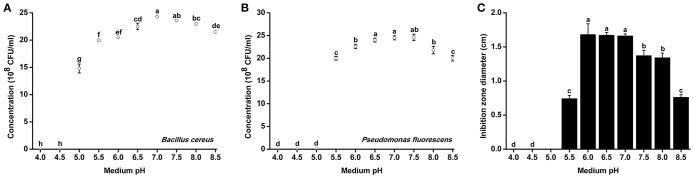
Growth rate and antagonistic activity of representative antagonistic bacteria under different pH conditions. Bacillus cereus
(A) and Pseudomonas fluorescens
(B) were grown in Broth medium with different pH for 48 h, and the bacterial concentration was determined using a nephelometer. (C) The antagonistic activity of B. cereus against R. Solanacearum was evaluated using the Oxford cup assay and was determined based on the inhibition zone diameter. Each point represents the average value of three replicates, and error bars indicate the standard deviation. Small letters indicate a significant difference among different pH conditions (ANOVA, Duncan's multiple test).